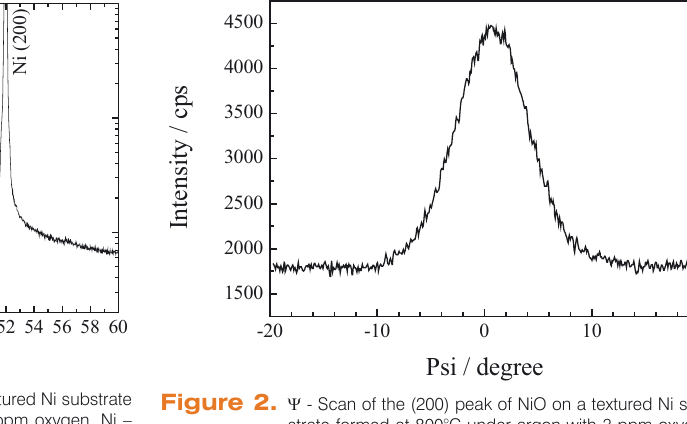
Figure 2. Y - Scan of the (200) peak of NiO on a textured Ni sub- strate formed at 800°C under argon with 3 ppm oxygen (FWHM: 7.8°).